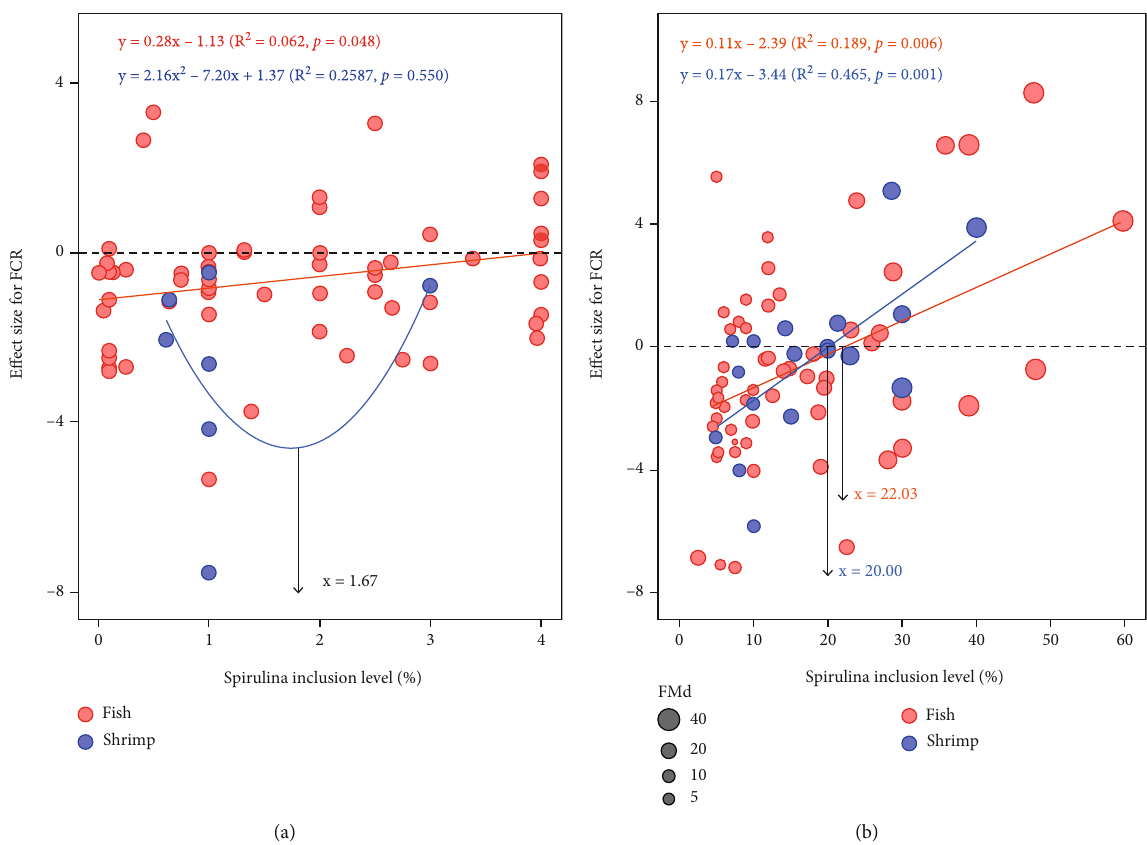
Figure 6: Random-e ff ects model regression of spirulina meal inclusion level as a feed additive (a) and feed ingredient (b) on the e ff ect size of FCR. The circle size represents the replaced level (%) of fi shmeal by SPM, in other words, it means the di ff erence of fi shmeal content between the control group and SPM supplemented